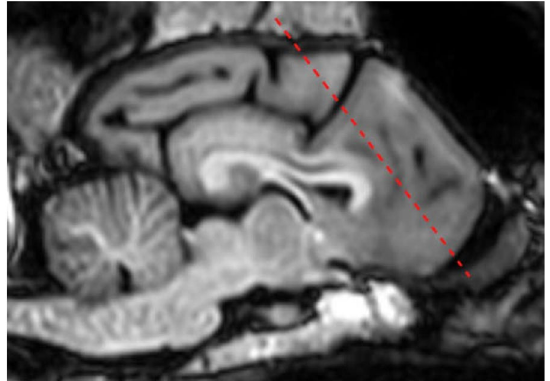
Figure 3. Guideline to flag clusters with a high-risk of susceptibility. We considered the dashed red line as the boundary corresponding to the largest extent of the susceptibility artefact, clusters with a center (investigated with multiple thresholds) anterior to this line would have been considered as susceptibility